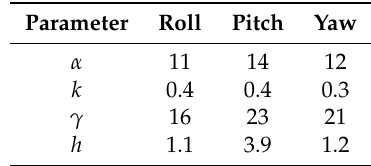
Table 2. Parameters of the backstepping sliding-mode